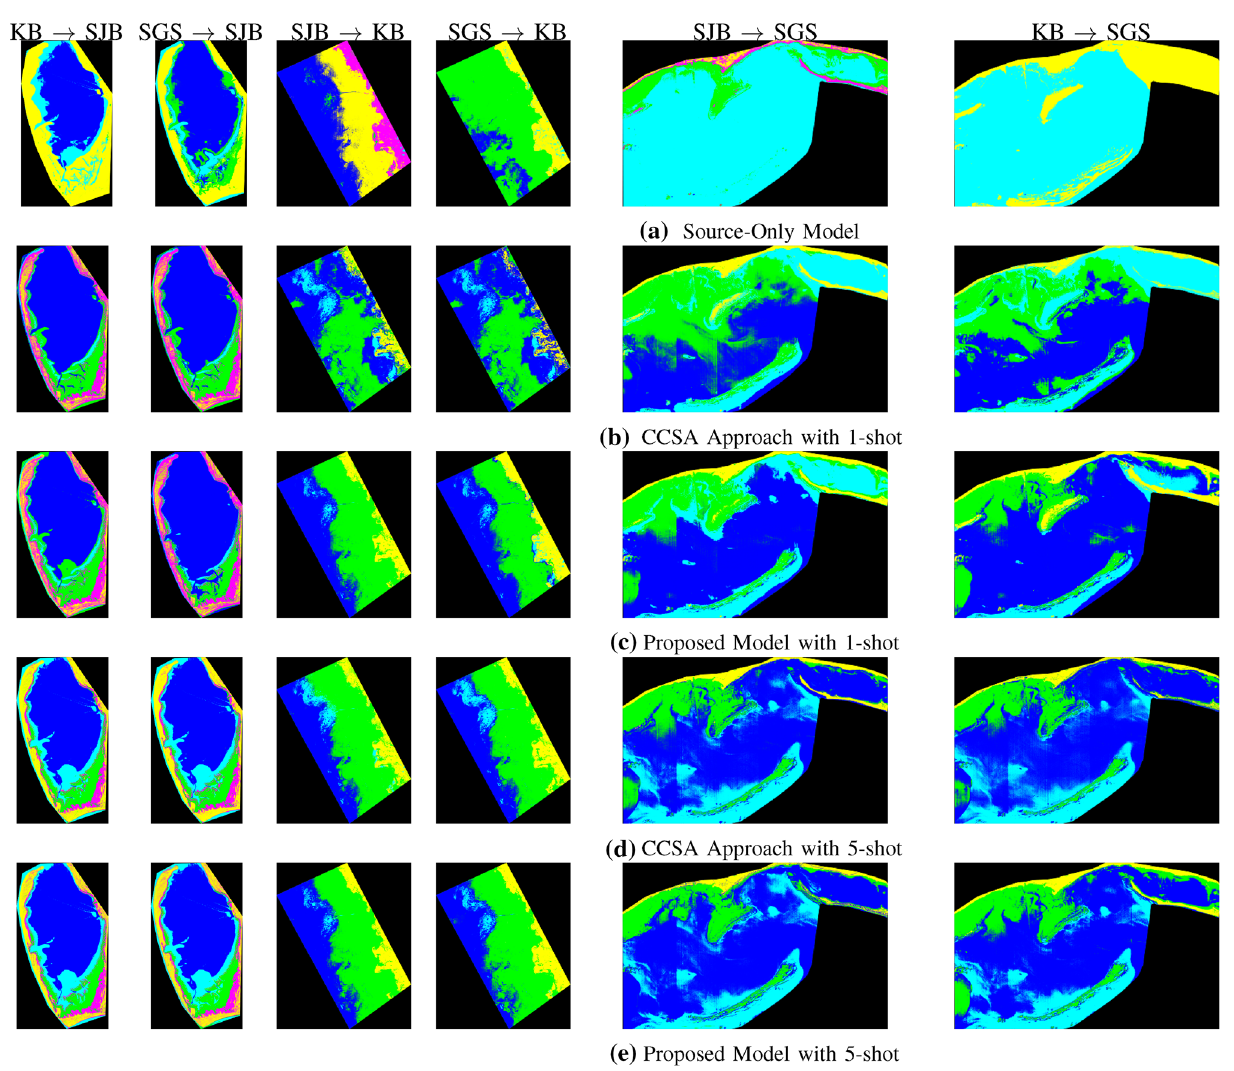
Fig. 6 End-to-end classification maps produced by domain adaptation based on a source model b CCSA model with 1-shot c proposed model with 1-shot d CCSA model with 5-shot and e proposed model with